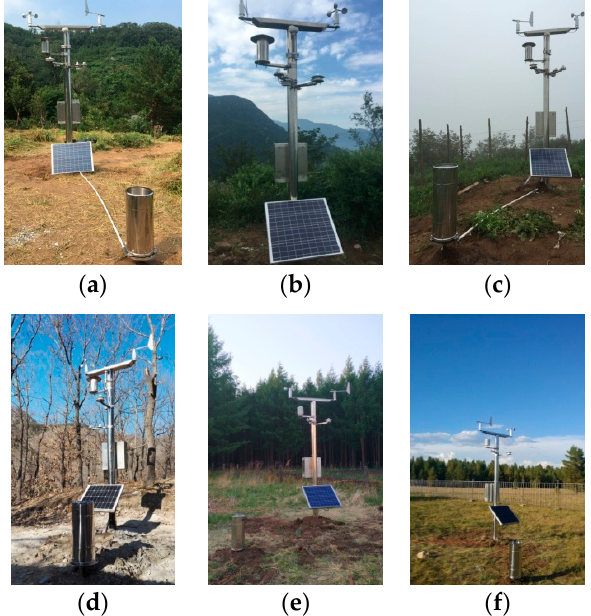
Figure 3. Forest microclimate monitoring stations in Beijing and Inner Mongolia. ( a ) Yan’er Ridge; ( b ) Wangjing Tower; ( c ) Luobadi; ( d ) Zhai’er Yu; ( e ) Hulun Buir; ( f ) Zhalantun.